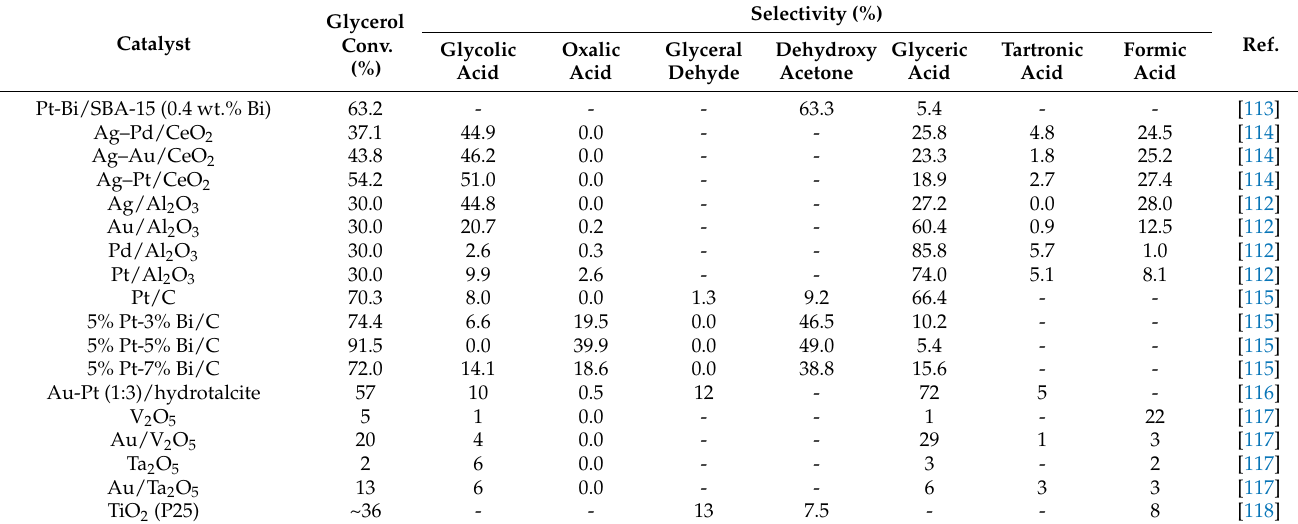
Table 3. Performance of different catalysts used in oxidation of